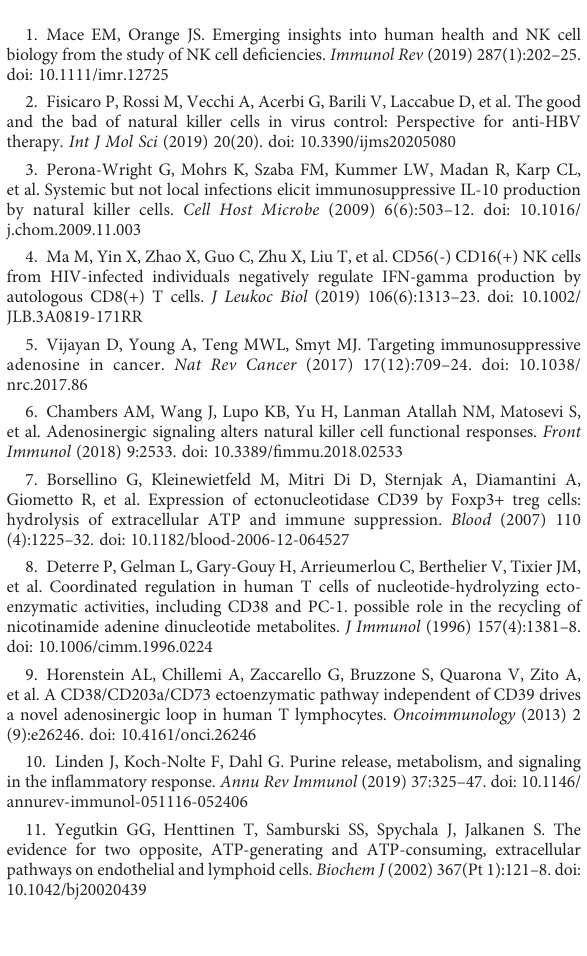
SUPPLEMENTARY FIGURE 1 The expression of CD73onNK, CD3 + CD4 - Tand CD3 + CD4 - Tcellsin HC, untreated HIV, and ART-treated